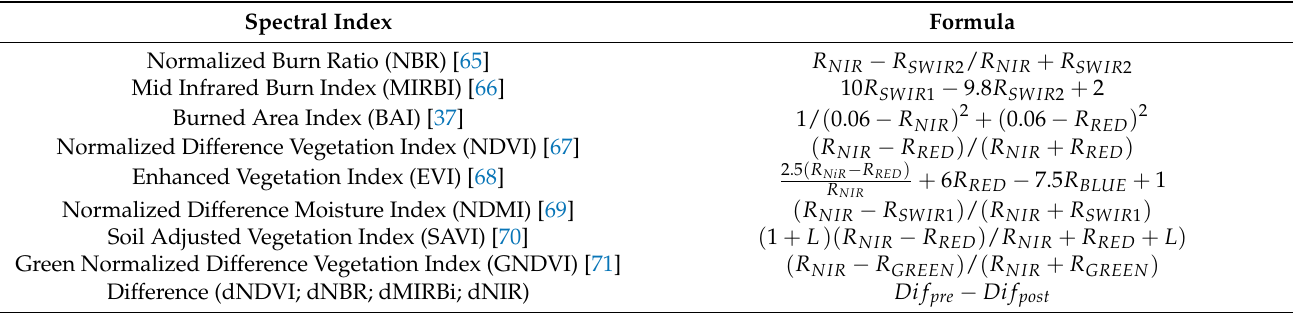
Table 2. Spectral indices for evaluation of the burnt area. The delta version of each index as the difference between pre- and post-fire values was tested in this